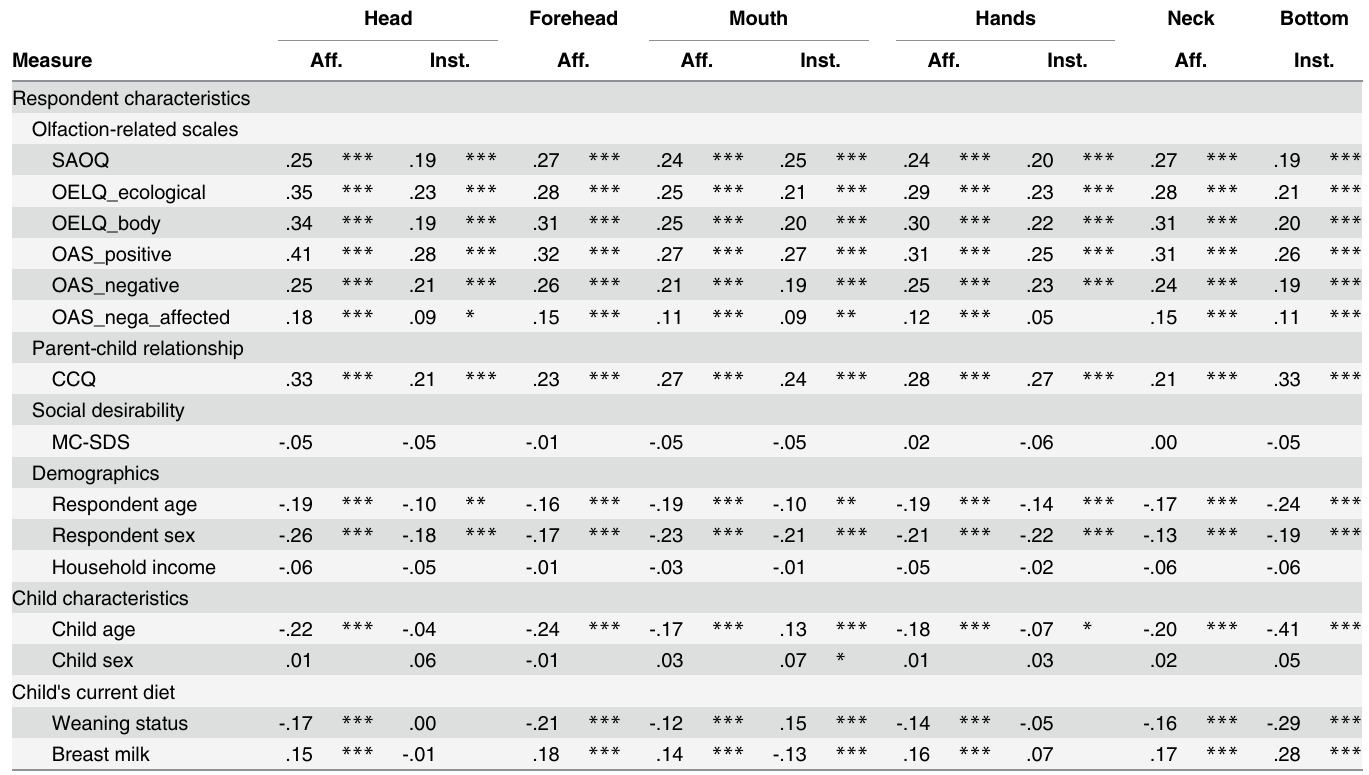
Table 3. Correlation between scores for the Child Odor in Parenting scale (COPs) and related measures ( n = 888). Head Forehead